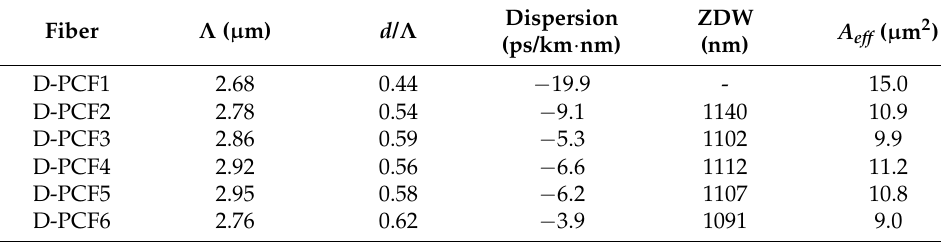
Figure 7. ( a ) SEM images of D 2 O-filled PCFs cross-section. ( b ) Chromatic dispersion of PCFs with holes filled with D 2 O. Dashed vertical black line indicates the experimental pump wavelength. Table 3. Structural parameters, dispersion and effective mode area at 1064 nm of D 2 O-filled PCFs.